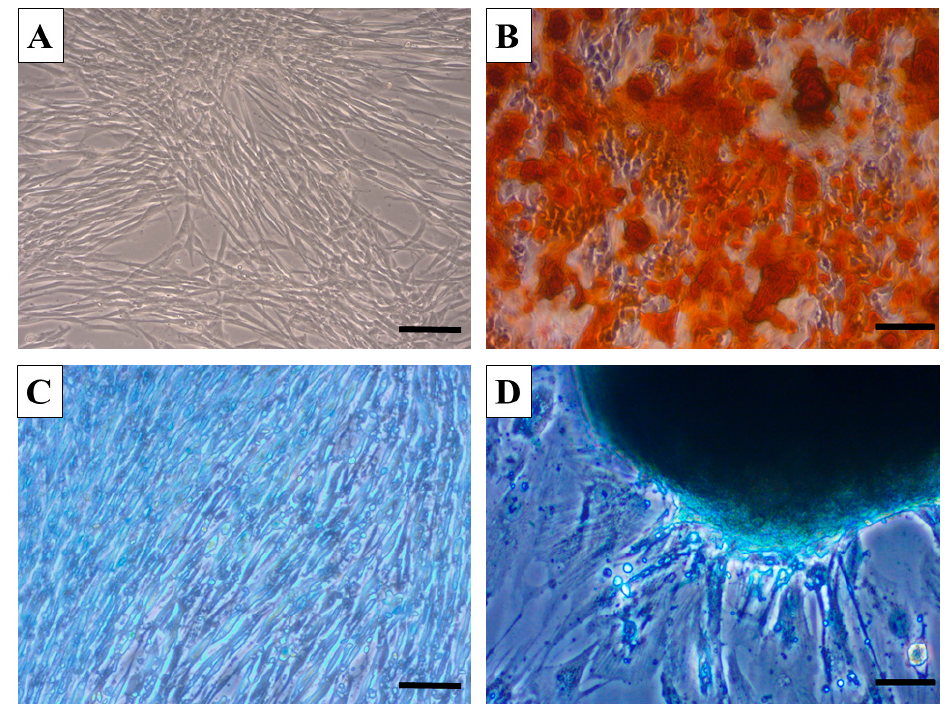
Figure 2. Micrographs documenting multipotent characteristics of canine BMMSC. Note differentiation into osteocytes ( B , Alizarin Red) compared to control ( A ) and chondrocytes ( D ), Alcian Blue) compared to control ( C ). Scale bars A, B, C, D = 50 μ m.